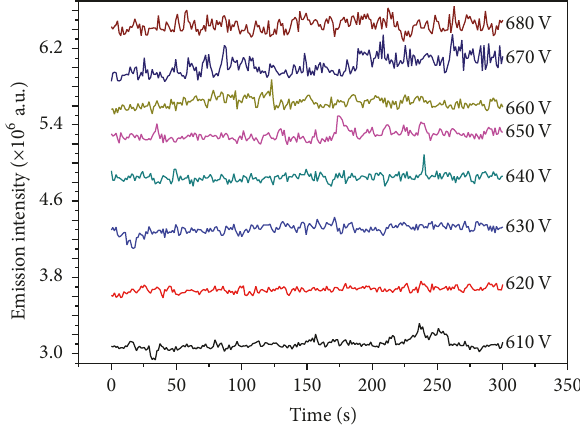
Figure 4: Stability of emission intensity as a function of time of LCGD (electrolytes: 5mg L −1 K solution adjusted to pH = 1.0 with HNO 3 , flow rate: 3mL min −1 , interelectrode gap: 2mm, and capillary diameter: 1